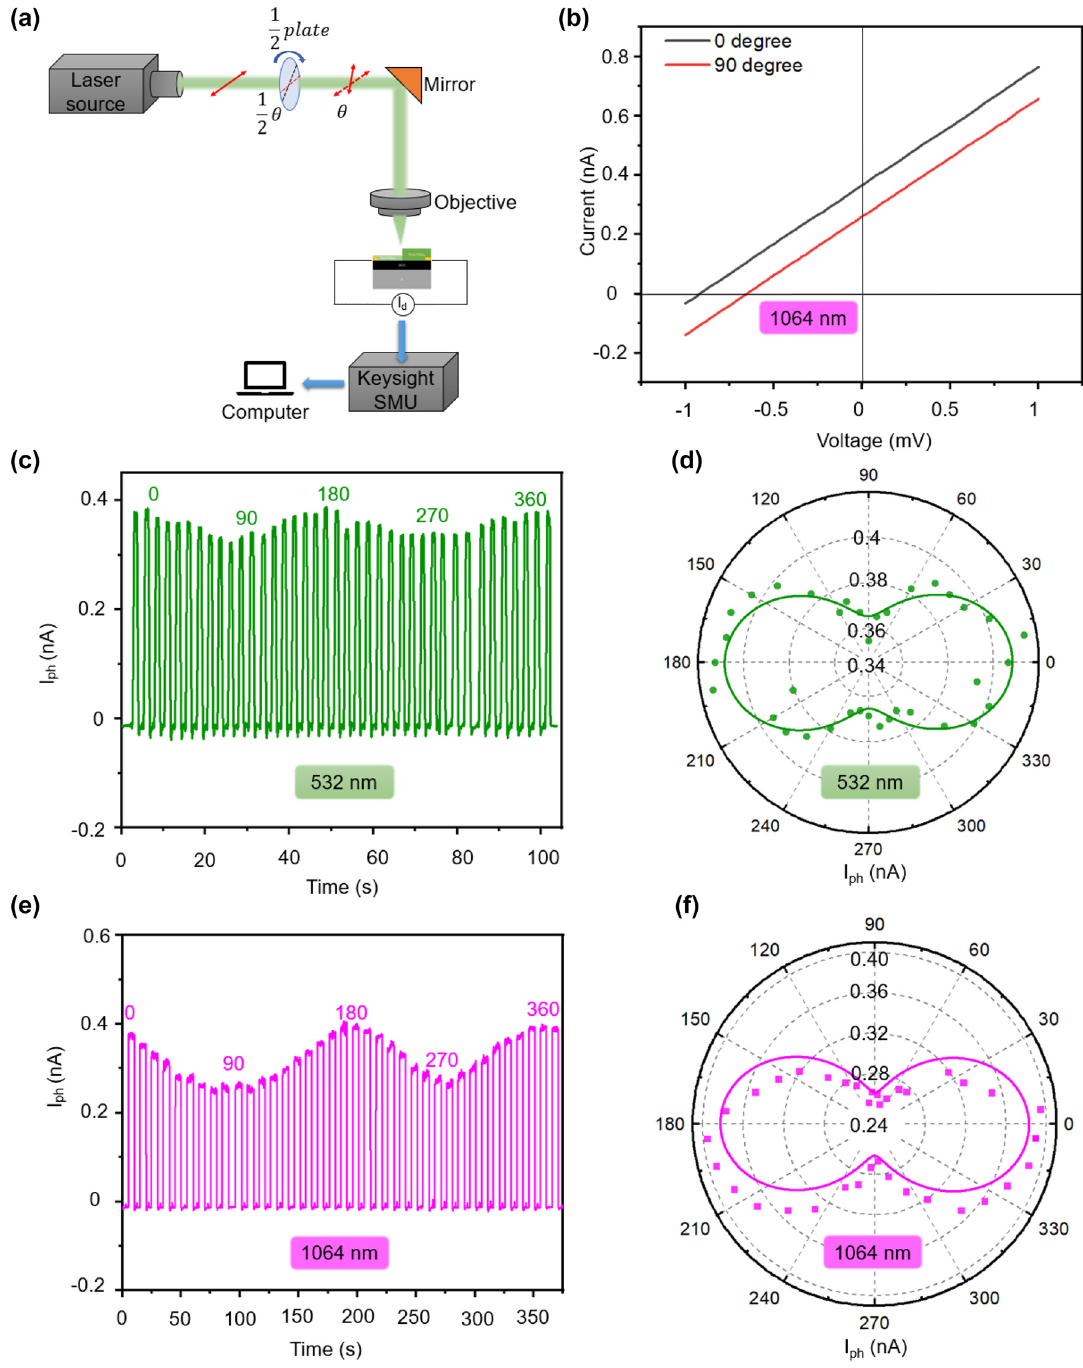
Figure 4: Polarized photoresponse of the PdSe photodetector. (a) Schematic illustration of a photodetector measurement system for analyzing linear 2 polarization sensitive response. (b) The I – V curves of the device under 1064 nm illumination with linear polarization angles of 0 ◦ and 90 ◦ . (c) and (e) The linear-polarization-angle dependent photocurrents under 532 nm (c) and 1064 nm (e) light illuminations. Here 0 ◦ corresponds to the angle of the . (d) and (f) The generated incident light when the laser polarization direction is aligned with the x -direction of the asymmetric-thickness PdSe 2 photocurrent as a function of the polarization angle of the laser. All the dots in (d) and (f) are fitted with the ( a + b cos 2 𝜃 )